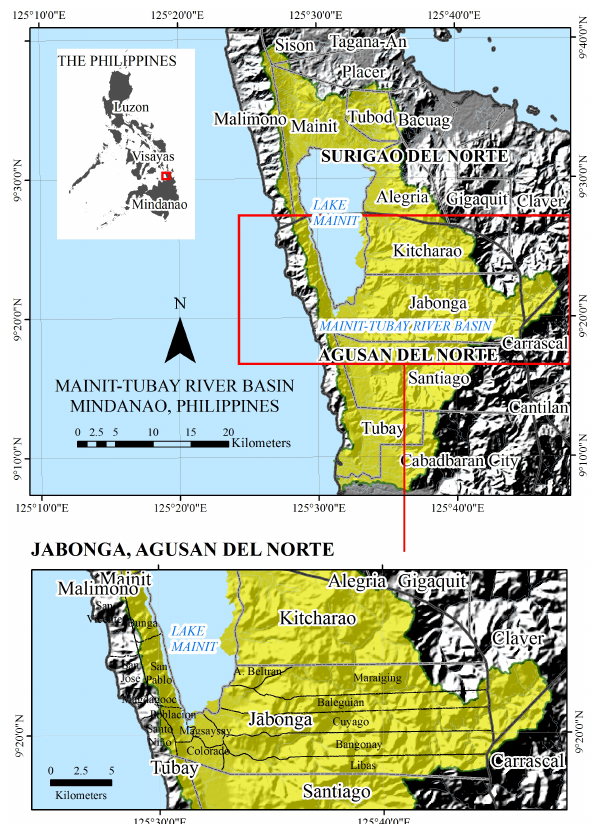
Figure 1: Series of maps showing the location of Jabonga munic- ipality within the Mainit-Tubay River Basin in Mindanao, Philip-